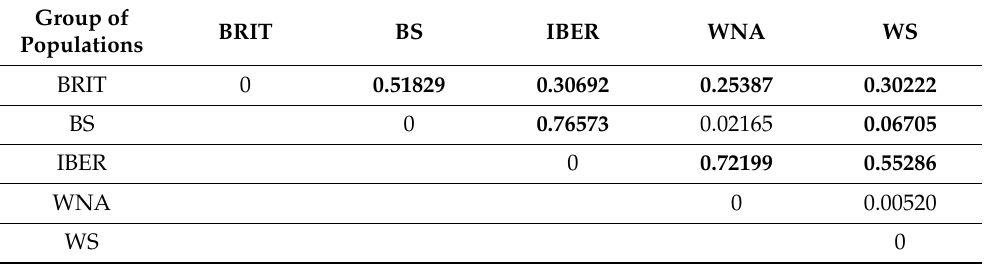
Table 3. Mean genetic divergences (Tajima and Nei FST distances, %, statistically significant values with p < 0.05 are in bold) for the COI dataset between groups of Margaritifera margaritifera populations.